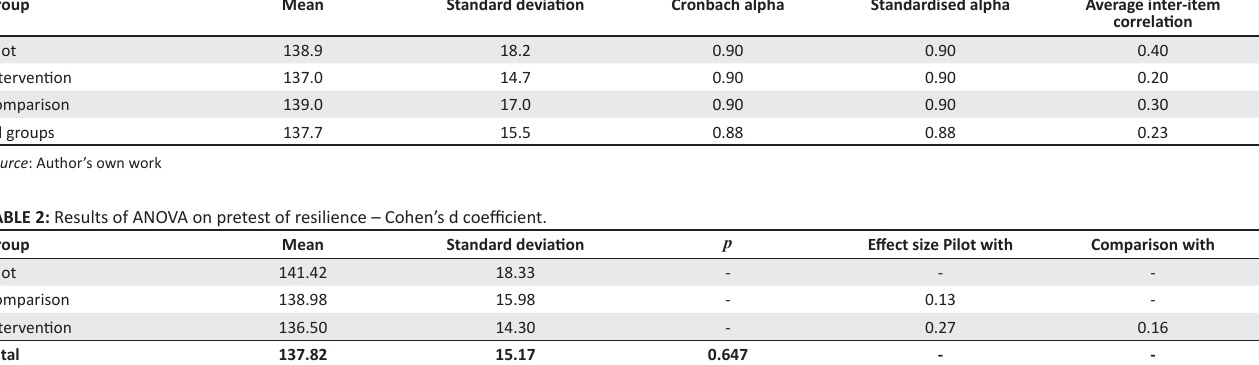
TABLE 1: Cronbach’s alpha reliability coefficient before intervention. Group Mean Standard deviation